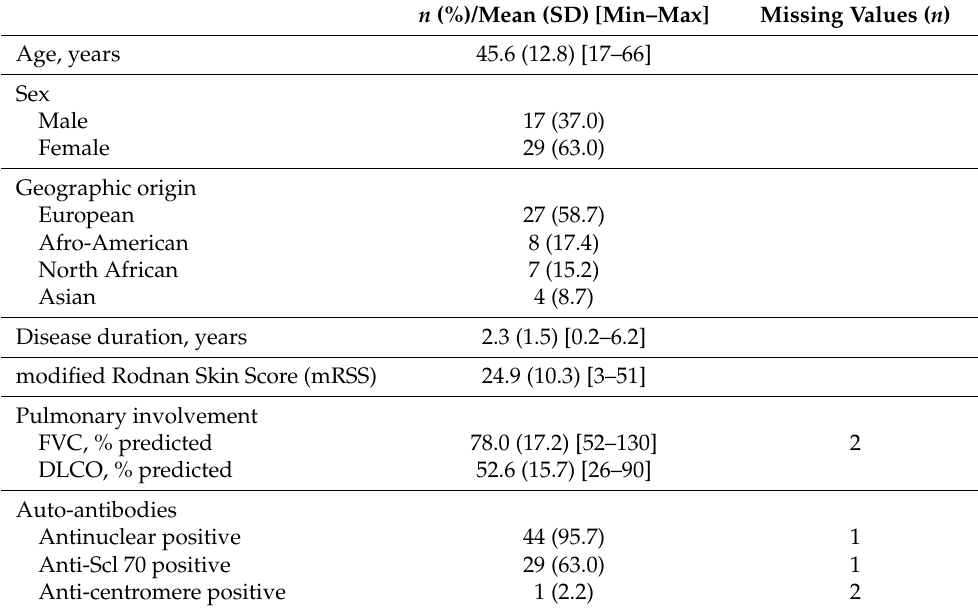
Table 1. Demographic and clinical characteristics of 46 Systemic Sclerosis patients before autologous hematopoietic stem cell transplantation